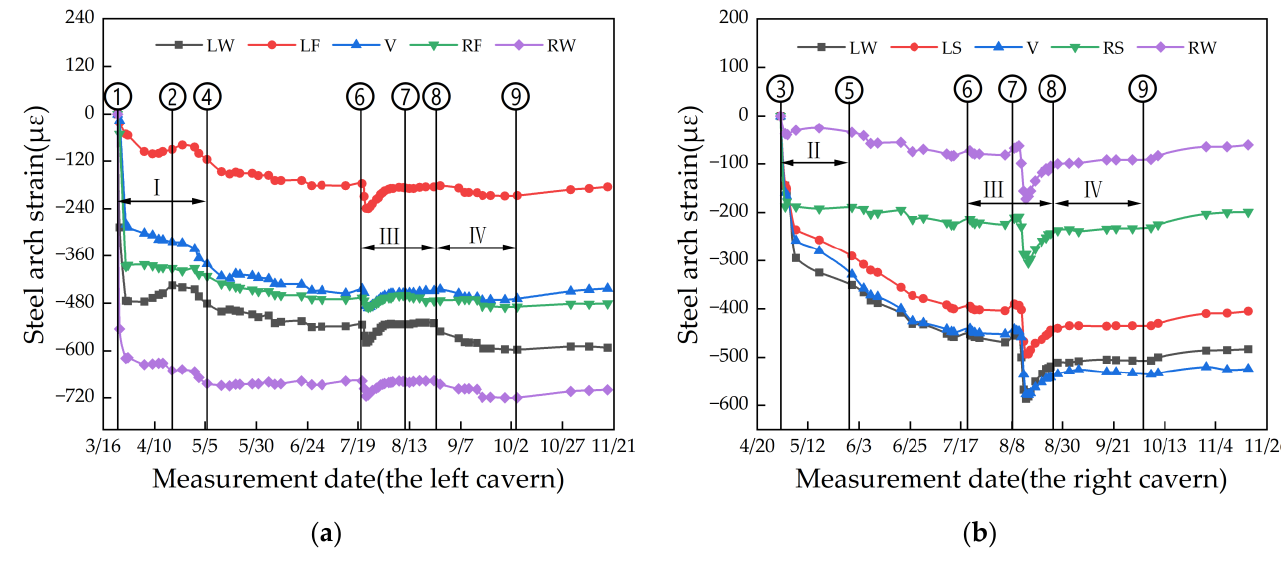
Figure 5. Strain distribution of the steel arch versus time. ( a ) Left cavern; ( b ) right cavern